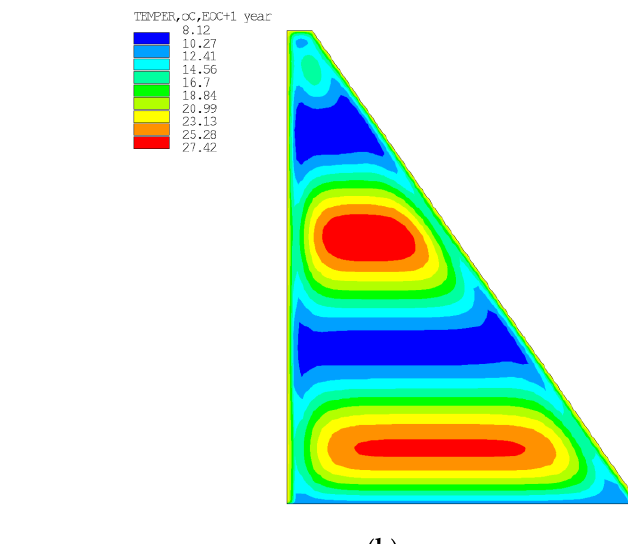
Figure 8. Example of calculating the maximum temperature in a concrete mass: ( a ) Calculation taking into account solar radiation; ( b ) Calculation excluding solar radiation.